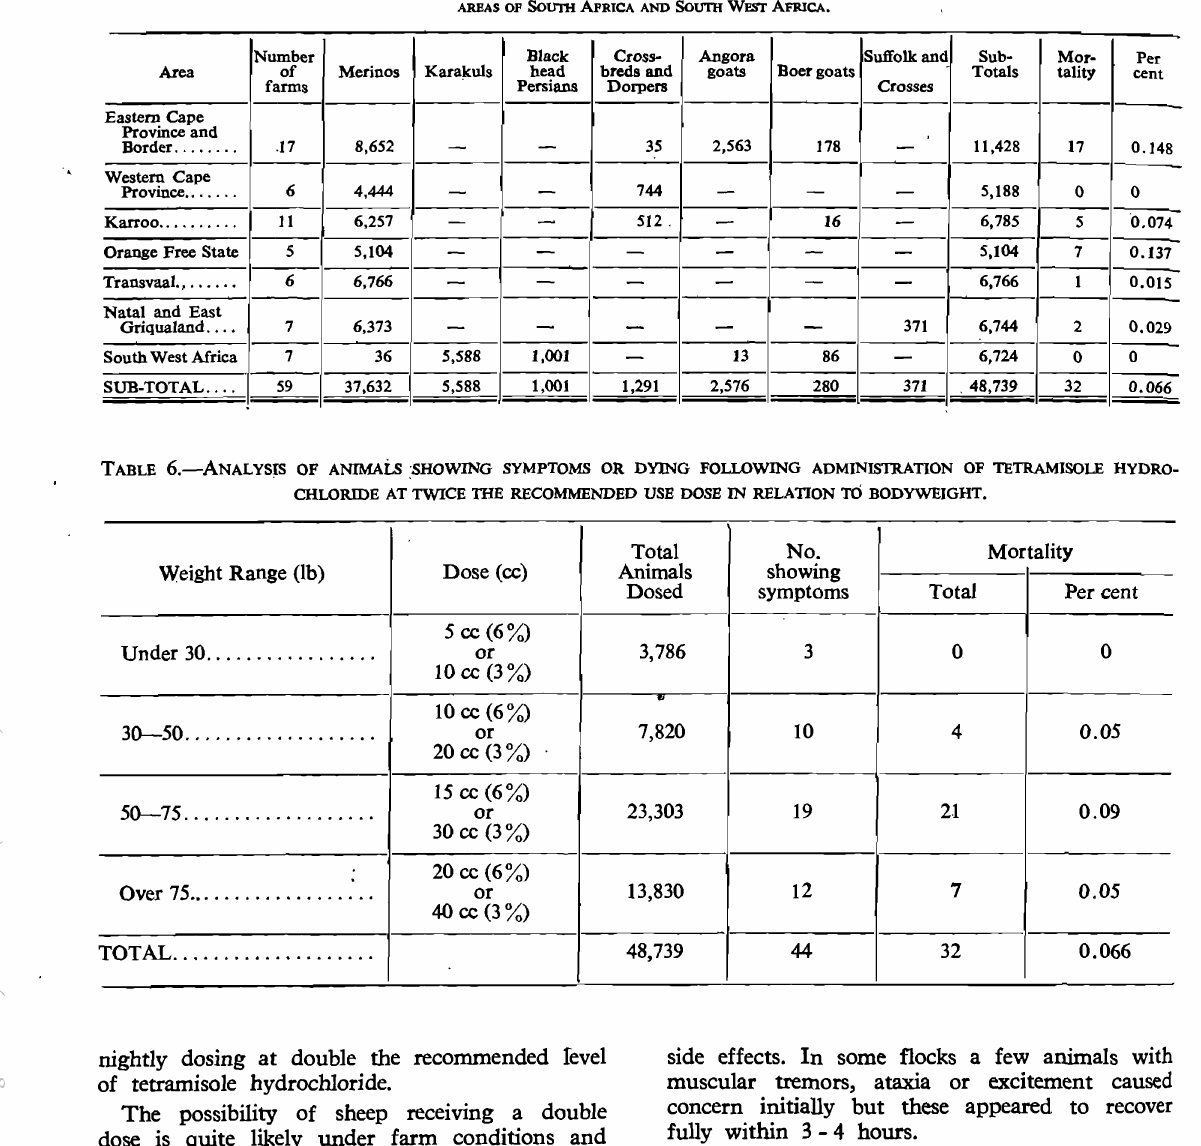
TABLE 5.-SUMMARY OF THI! RESULTS OF DOSING SHEEP AND GOATS AT TWJCE THE RECOMMENDED USE DOSI! OF TETRAMISOLl! HYDROCHLORIDE IN VARIOUs. AREAS OF SoUTH AFRICA AND SoUTH WFSr AFRICA.